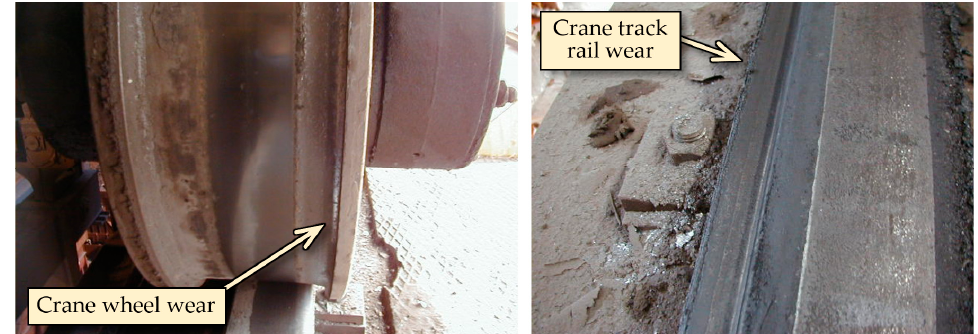
Figure 3. Examples of wear on the crane wheels and crane track rails.